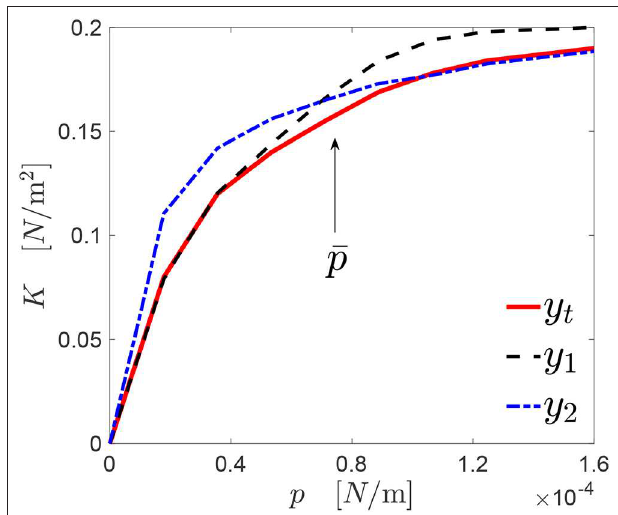
FIGURE 4 | A generic profile y 1 ( p ) approximates the target response y t ( p ) [here, K ( p )] accurately under a certain level of pressure another profile y 2 ( p ) provides a good approximation of y t ( p ) only above